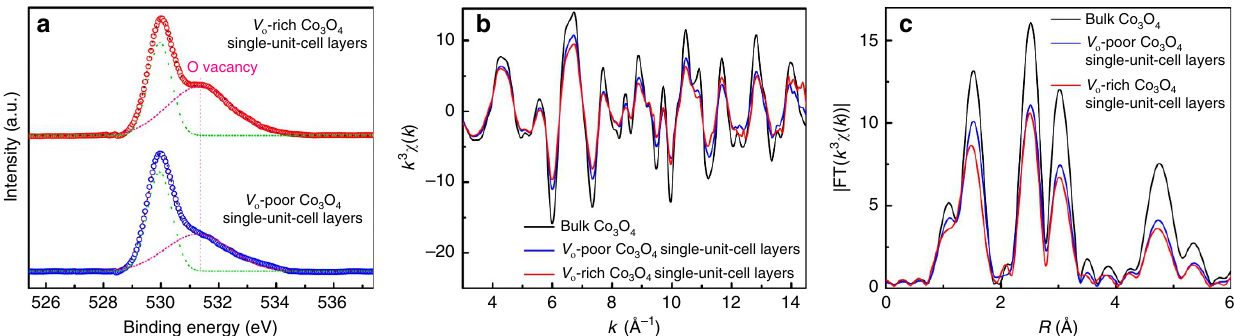
Figure 2 | XPS spectra and synchrotron radiation XAFS measurements. ( a ) O 1 s XPS spectra of V o -rich and V o -poor Co 3 O 4 single-unit-cell layers. ( b ) Co K-edge extended XAFS oscillation function k 3 w ( k ). ( c ) The corresponding Fourier transforms FT( k 3 w ( k )). excellent structural stability 24,28,29 . More importantly, the coordi- For the V o -poor Co 3 O 4 single-unit-cell layers, the coordination numbers for Co-O, Co-Co 1 , Co-O 1 , Co-Co 2 and Co-O 2 coordi- nation numbers for Co-O, Co-O 1 and Co-O 2 coordinations, nations reduced, while their disorder degrees increased compared confined in the V o -rich Co 3 O 4 single-unit-cell layers, further decreased as compared with the V o -poor Co 3 O 4 single-unit-cell with bulk counterpart, which implied the presence of many dangling bonds as well as an obvious distortion on their surface. layers, while their coordination numbers for Co-Co 1 and Co-Co 2 The surface distortion in turn helped to endow them with coordinations did not show any noticeable variation (Table 1), NATURE COMMUNICATIONS|8:14503|DOI: